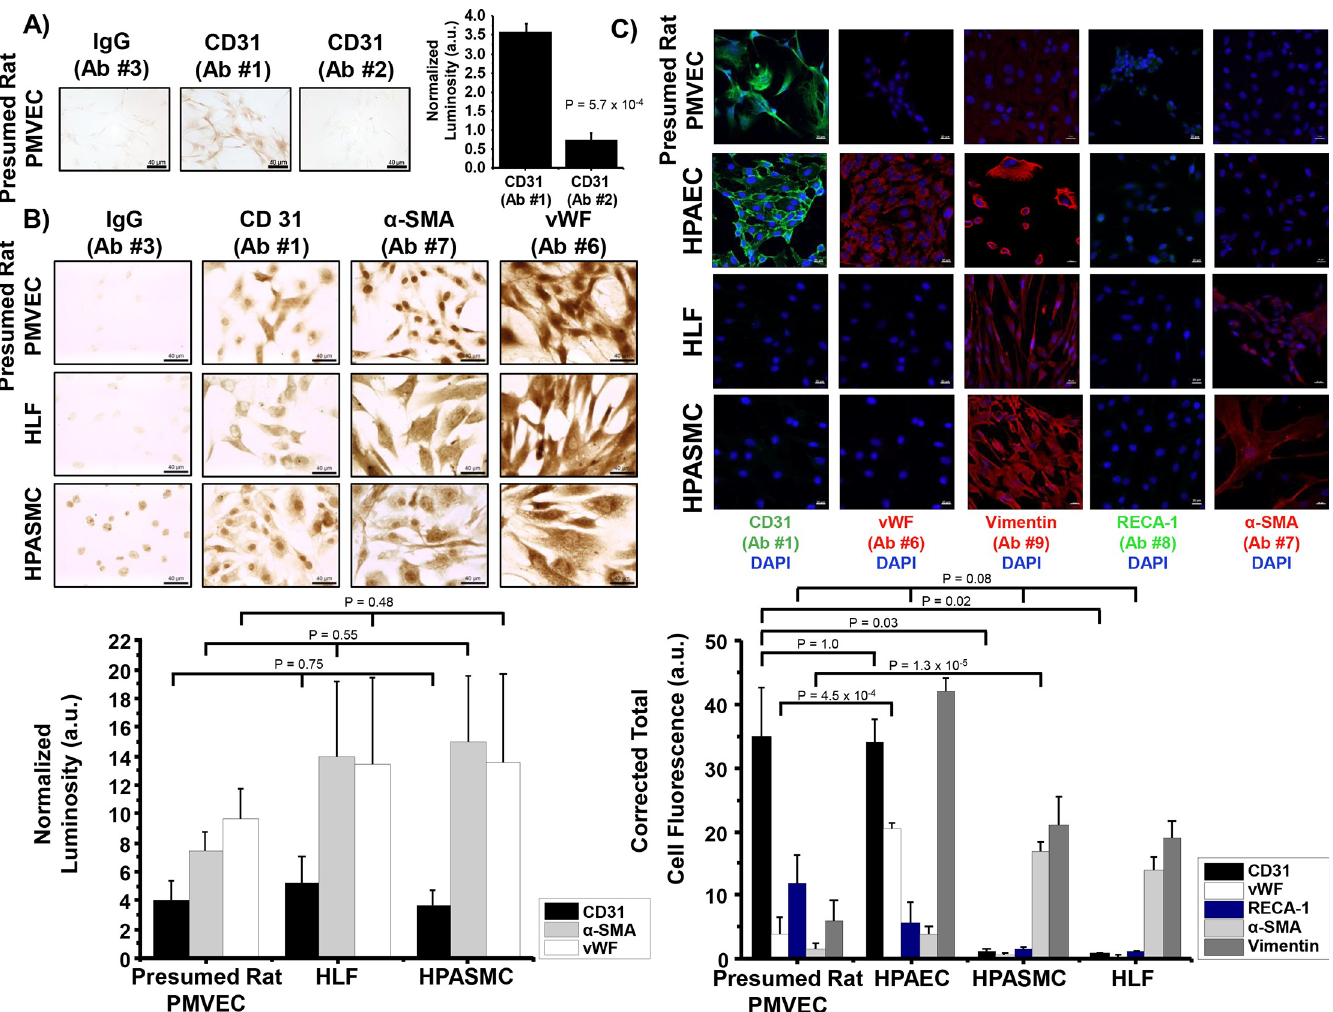
Fig 2. Immunocytochemistry and immunofluorescence were unsuccessful for definitively identifying presumed pulmonary microvascular endothelial cells (PMVECs) isolated from rats ex vivo . (A) Peripheral rat lung tissue underwent mechanical and enzymatic dissociation, and the cell pellet was cultured in endothelial- selective medium. Presumed rat PMVECs were analyzed using anti-CD31 Abs #1 and #2 immunocytochemistry (ICC). Luminosity was normalized to IgG control. (B) Anti-CD31 Ab #1, anti-von Willebrand factor (vWF) Ab #6, and anti-smooth muscle actin ( α -SMA) Ab #7 ICC performed in presumed rat PMVECs, human lung fibroblasts (HLFs) and human pulmonary artery smooth muscle cells (HPASMCs) shows no significant difference in signal intensity by cell marker across different cell types. (C) Presumed rat PMVECs and HPAECs, HPASMCs, as well as HLFs as controls were analyzed by immunofluorescence (IF). Only CD31, and not vWF, signal was increased in presumed rat PMVECs compared to non-endothelial controls. Representative photomicrographs shown. a.u., arbitrary units. Student’s unpaired t-test or ANOVA. Means ± SE, N = 3-5/condition.